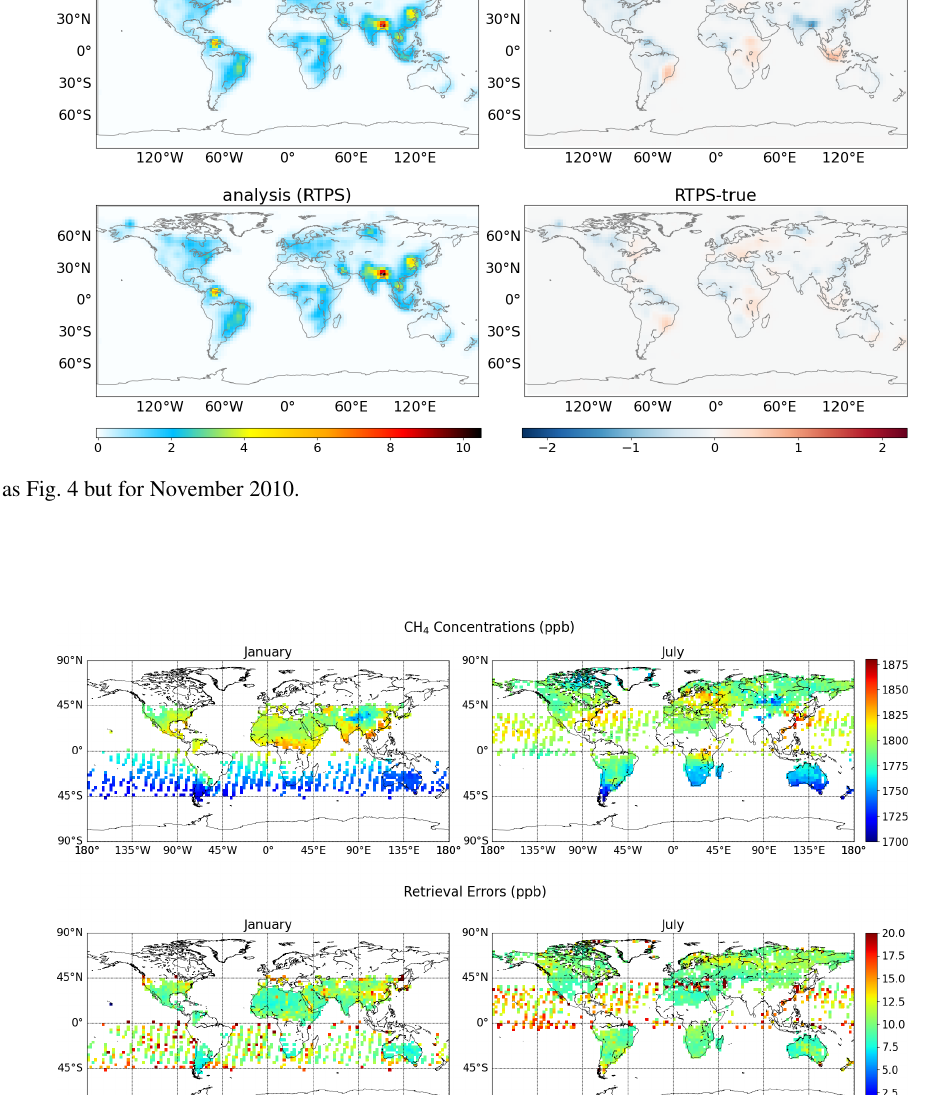
Figure 6. Monthly mean ACTM-simulated XCH 4 (ppb) sampled with GOSAT observations to be assimilated (valid during the year 2010). The actual retrieval errors are added in the synthetic GOSAT observations. Data are shown for 2 representative months, depicting the Southern and Northern Hemisphere differences in data